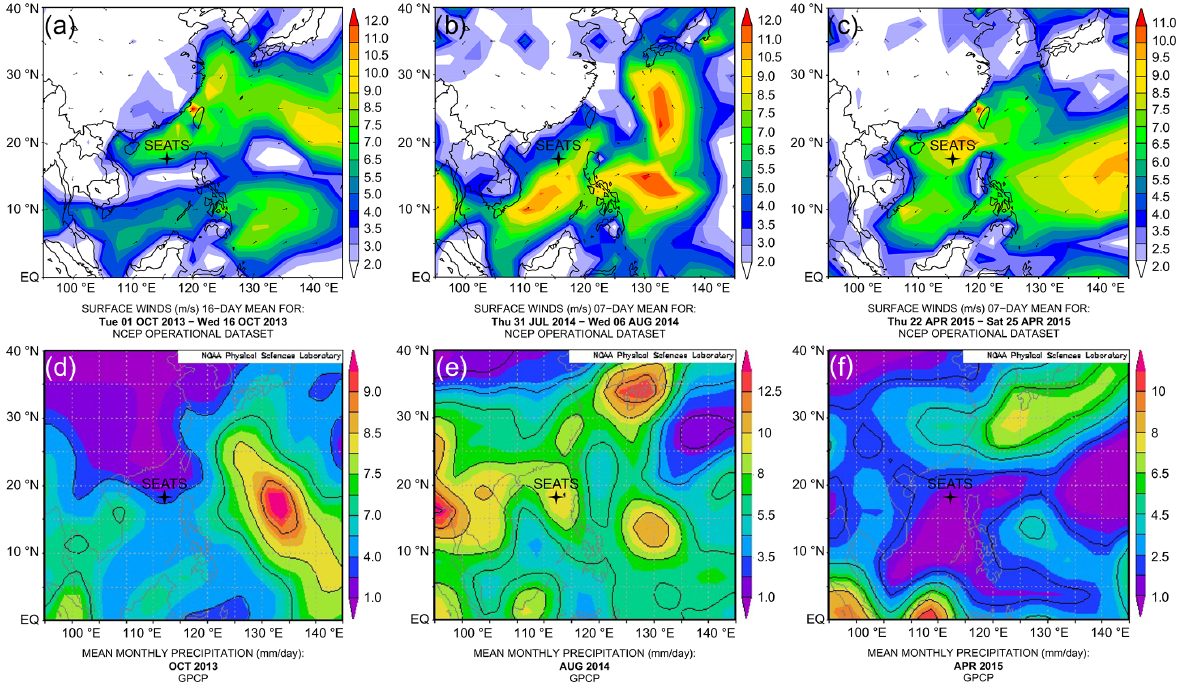
Figure 2. Upper panels – surface vector wind maps indicating the monsoon seasons: (a) inter-monsoon period in October 2013; (b) southwest summer monsoon in August 2014; (c) northeast winter monsoon in April 2015. Lower panels – mean monthly precipitation: (d) in October 2013; (e) in August 2014 and (f) in April 2015. Maps of vector wind distributions were obtained from the NOAA – Atmospheric Variables Plotting Page using the NCEP daily analysis data (https://www.esrl.noaa.gov/psd/data/histdata/, last access: April 2020). Maps of precipita- tion were obtained from NOAA’s GPCP Version 2.3 Combined Precipitation Data Set (https://psl.noaa.gov/data/gridded/data.gpcp.html, last access: April